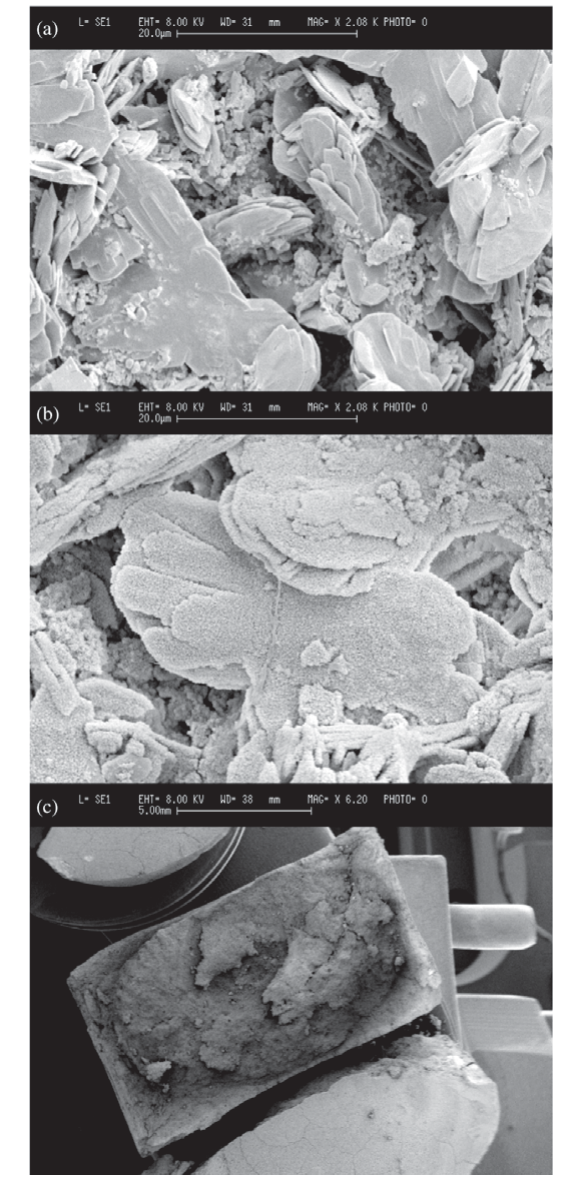
Figure 6. SEM micrographs of the fracture surface of cement: (a) before hydrolysis; (b) after 5 h of hydrolysis; (c) b at low mag- nification. (Cement: fine β -TCP; L/P = 1.0 ml/g; 1.0 M Na